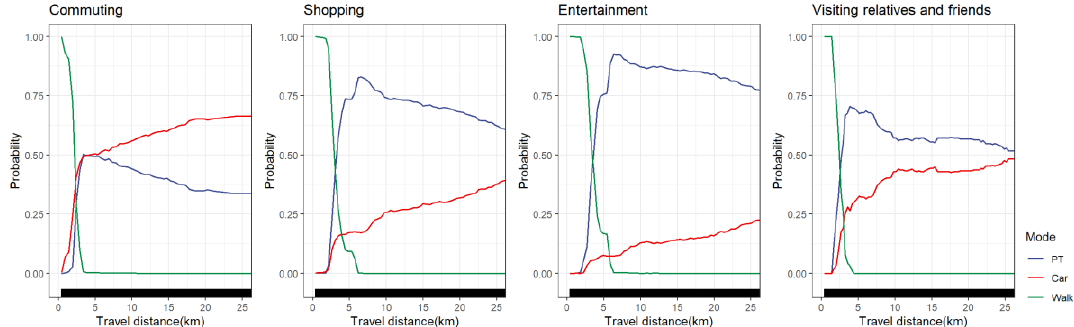
Figure 14. PDP plot of travel purpose groups differences.